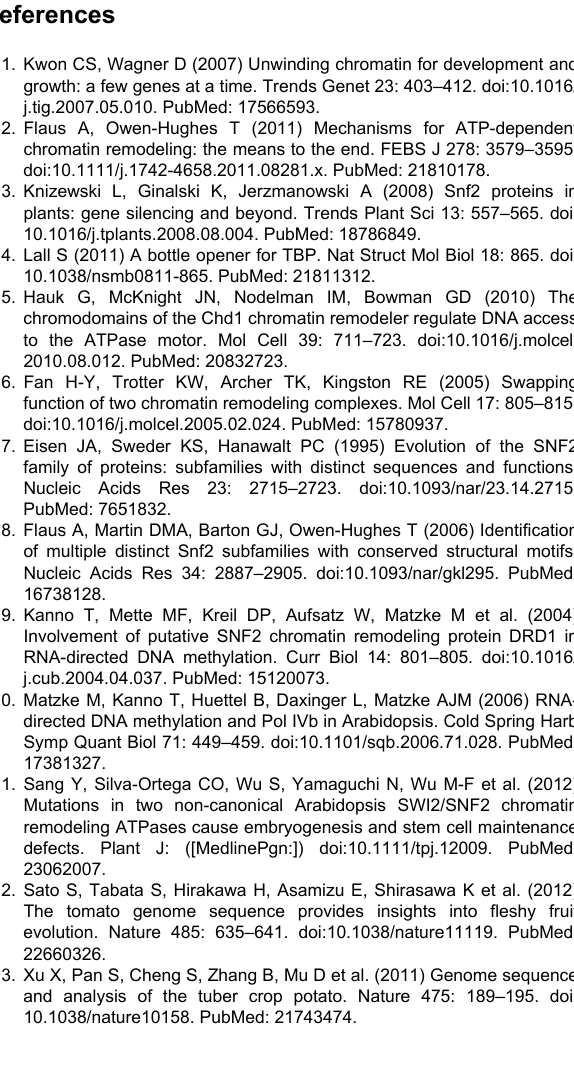
Dataset S1. Text file with custom predicted gene models